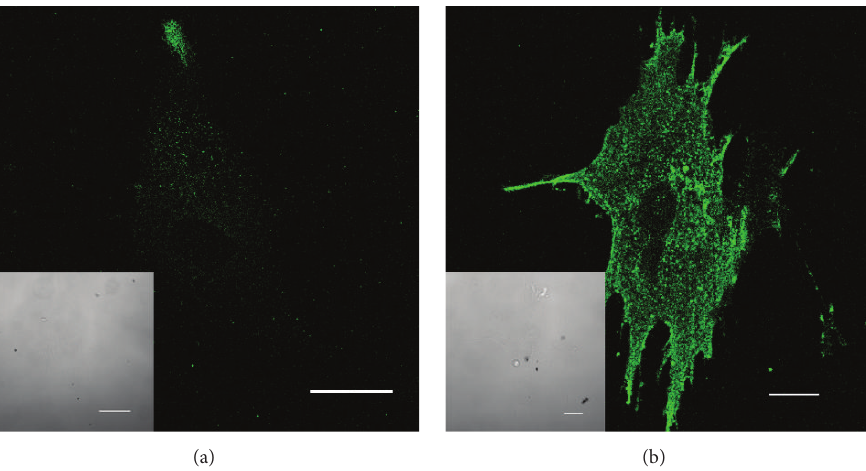
Figure 1: Expression of HIF-1 𝛼 , a hypoxia marker, in human preadipocytes cultured in vitro . Confocal images and transmission light images (insets)ofhumanpreadipocytesimmunolabeledwithantibodyagainstHIF-1 𝛼 .Preadipocyteswereculturedfor2daysinnormoxicconditions (a, 18% O 2 ) or hypoxic conditions (b, 1% O 2 ). Cells were fixed and immunolabeled with an antibody against HIF-1 𝛼 . Inserts show transmission light microscopy images of the same cells as in the confocal fluorescent images. Scale bars indicate 20 𝜇 m.